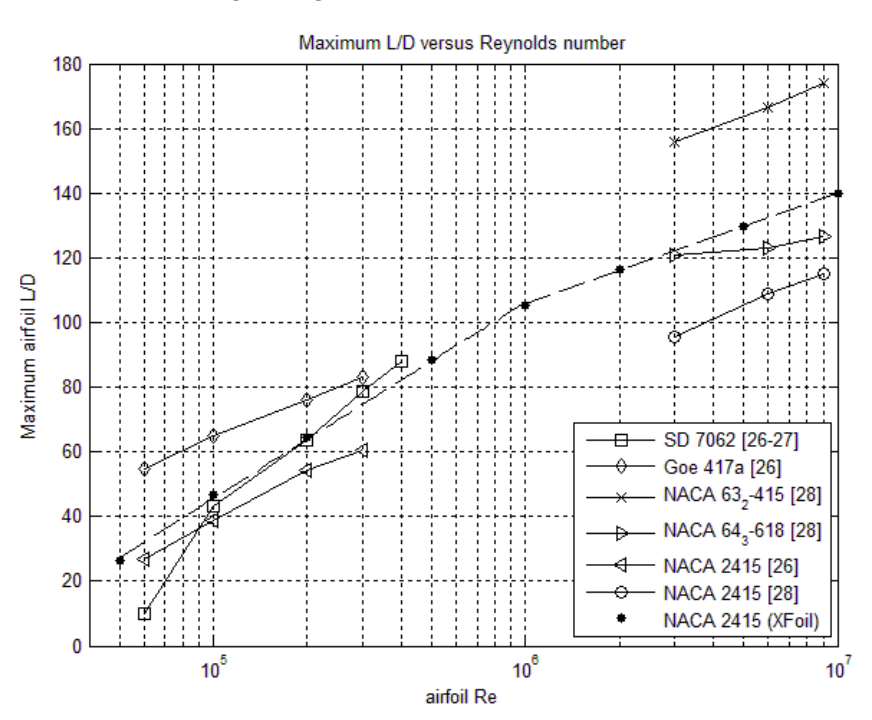
Figure 5. Measured maximum lift-over-drag ratio versus Reynolds number for selected airfoils relevant for use in Wind Turbine Generator (WTG) rotors, [26–28]. The NACA 2415 airfoil is included partly because it has been investigated both at low Re [26] and at high Re [28]. The dotted marker results for NACA 2415 were computed by the airfoil analysis program, XFoil [29]. The two dashed straight lines are linear curve-fits to the XFoil data for low and high Reynolds